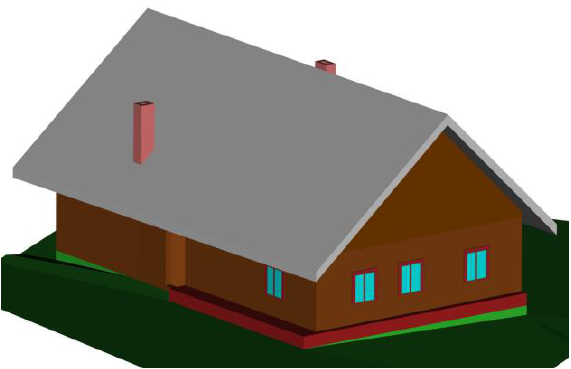
Figure 7. Example of the final 3D model of the examined building, Vigantice (Vsetín